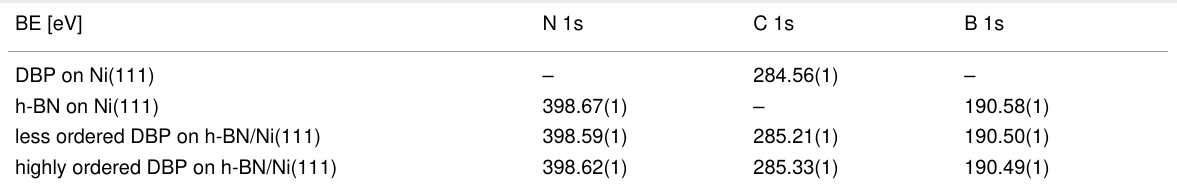
Table 3: Overview of the binding energies (BE) of the N 1s, C 1s and B 1s core levels for DBP on bare Ni(111) (approx. 1.0 MLE) as well as h-BN on Ni(111) and DBP on h-BN/Ni(111) (less ordered (approx. 1.0 MLE) and highly ordered (approx. 1.6 MLE)). The uncertainty of the numerical fitting pro- cedure is given in parentheses behind each value and refers to the last significant